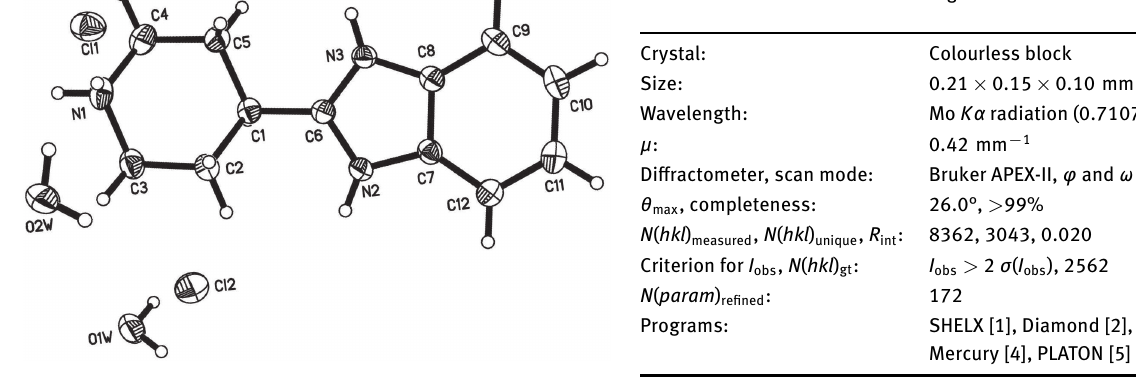
Table 1: Data collection and